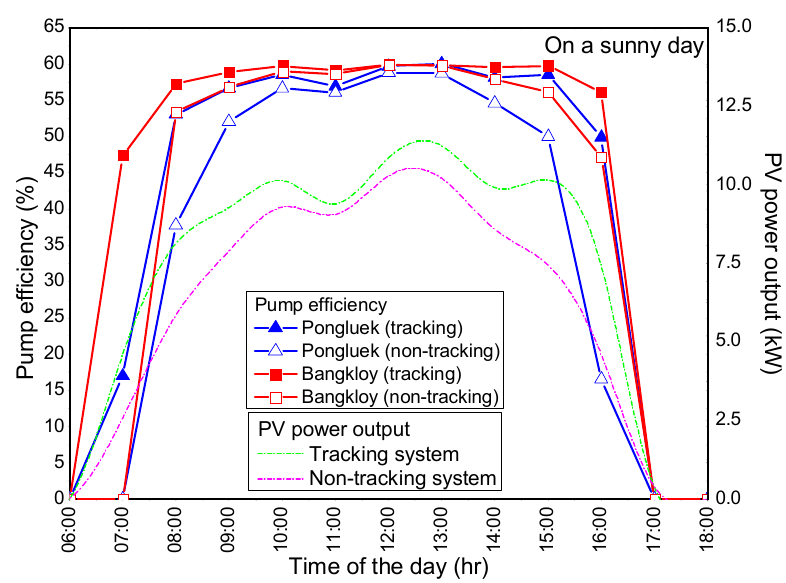
Figure 15. Pump efficiency at Pongluek and Bangkloy according to the PV power output on a sunny day for tracking and non-tracking SWSS.